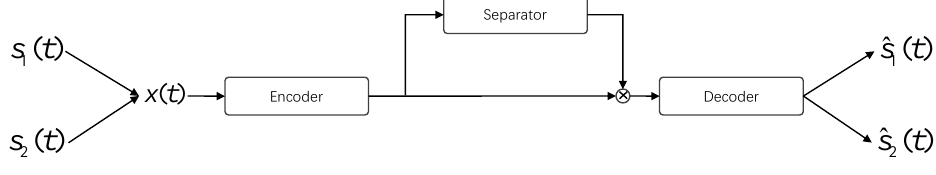
Figure 1. Simple representation of bird sound separation structure based on deep